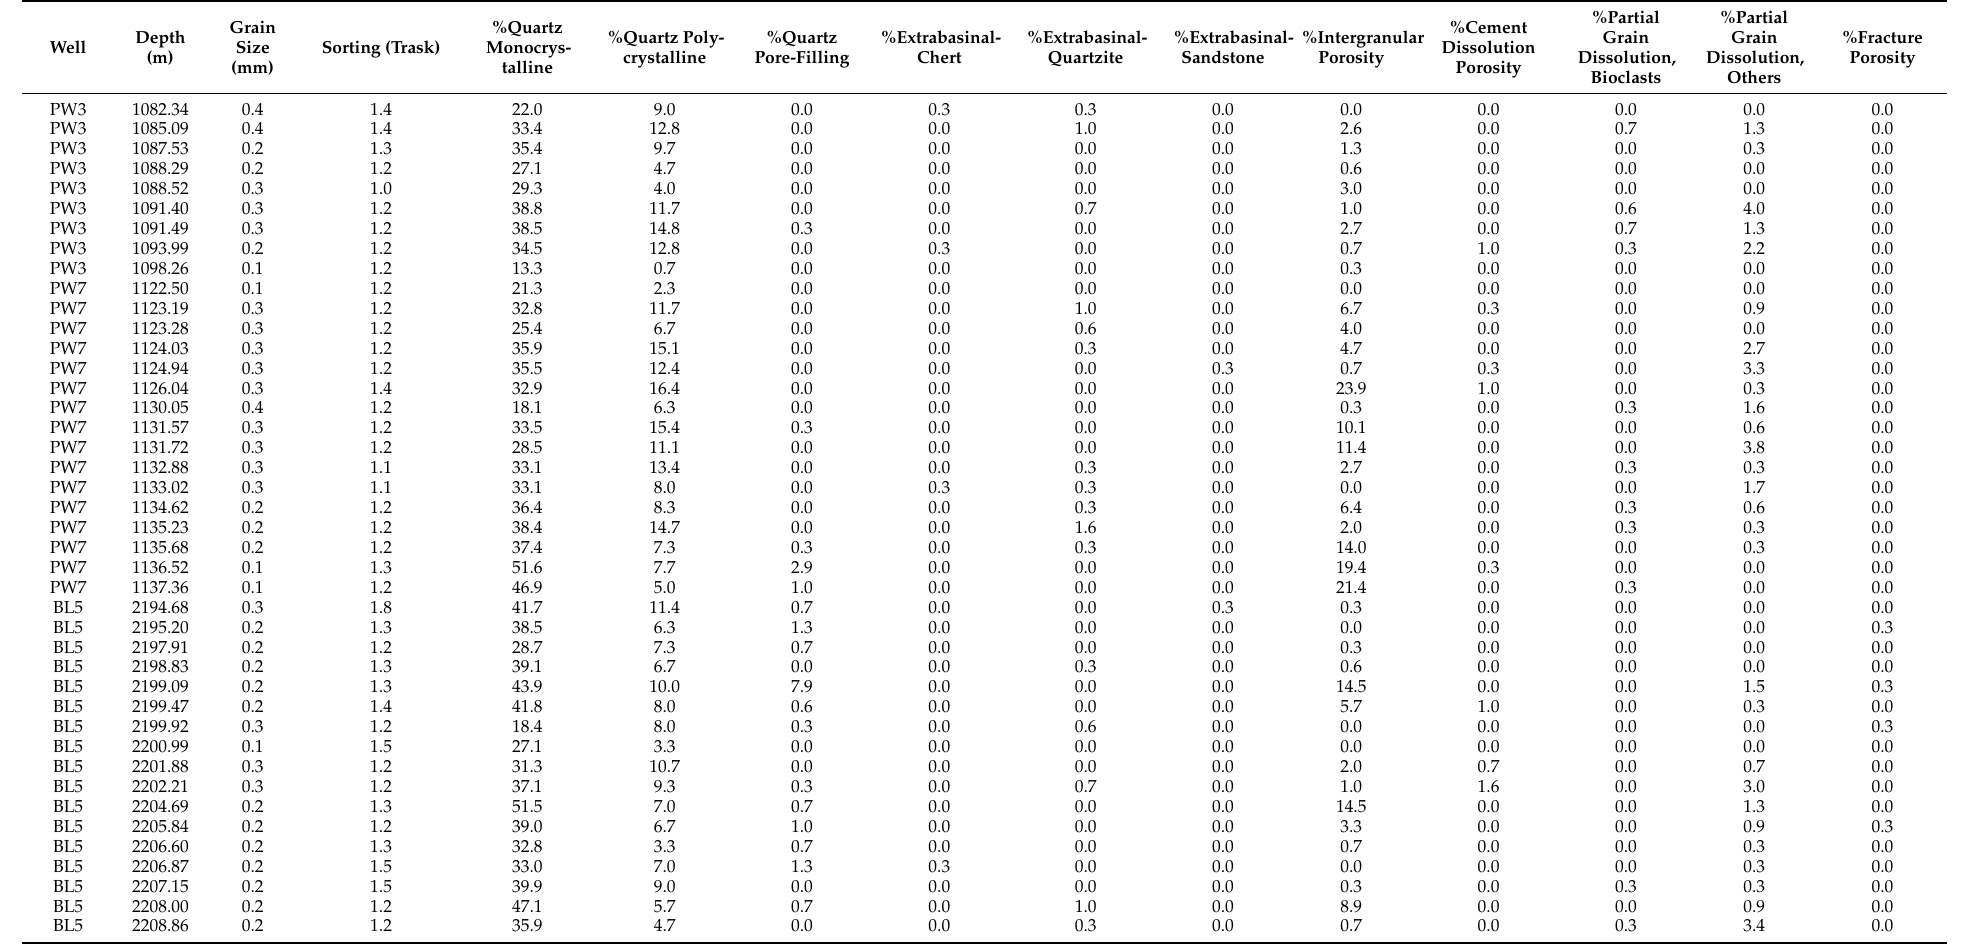
Table A1. Point count data for the Corallian